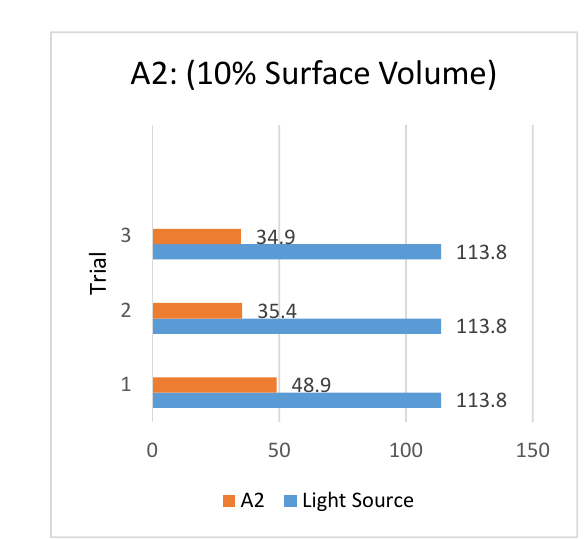
Fig. 18: Results from Tests on Block A1 (5%)